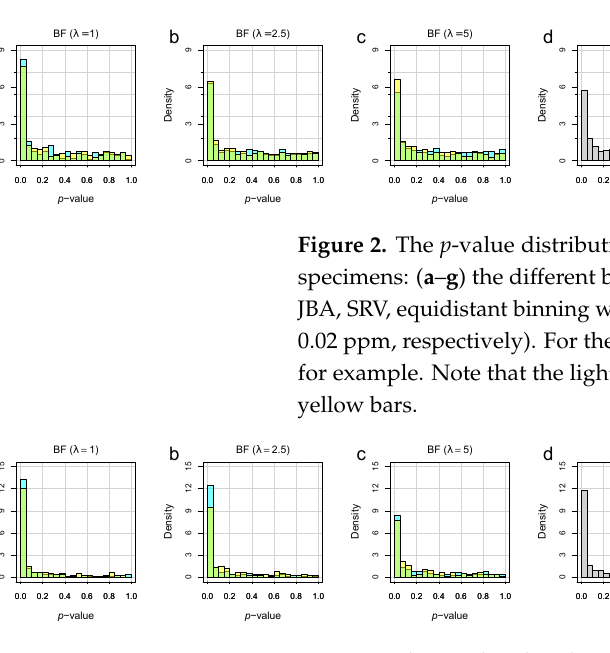
Figure 3. The p -value distributions of AKI versus non-AKI patients after cardiac surgery in plasma specimens: ( a – g ) the different binning approaches (BF with λ = 1, BF with λ = 2.5, BF with λ = 5, JBA, SRV, equidistant binning with a bin size of 0.01 ppm, and equidistant binning with a bin size of 0.02 ppm, respectively). For the BF method, the same color-coding was applied as that in Figure 1, for example. Note that the light green bars correspond to the overlapping regions of the cyan and yellow bars.